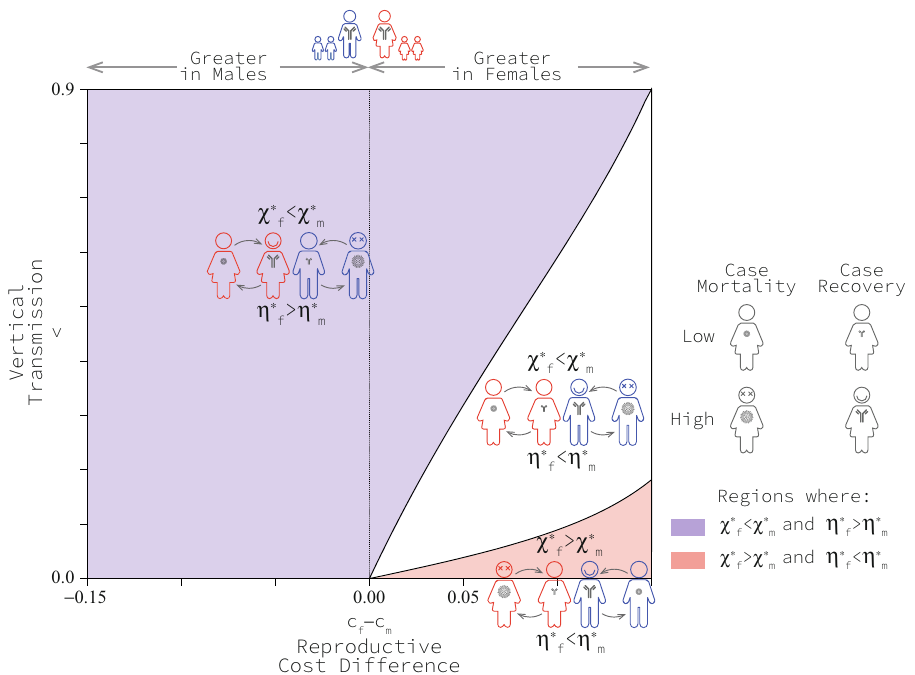
μ =0.1. See Methods for an explanation of model parameters. Source data are provided as a Source Data fi